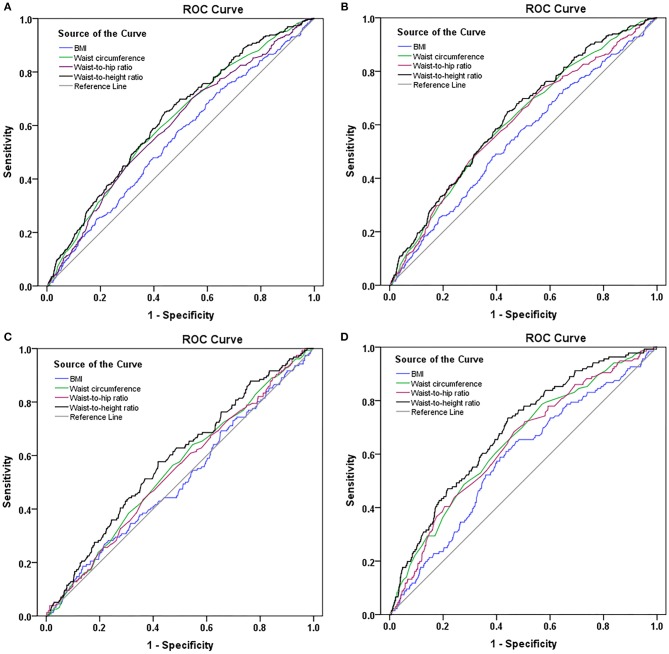
ROC curves of the body fat measuring indexes for stroke (A). ROC curves of the body fat measuring indexes for ischemic stroke (B). ROC curves of the body fat measuring indexes for stroke in males (C). ROC curves of the body fat measuring indexes for stroke in females (D).